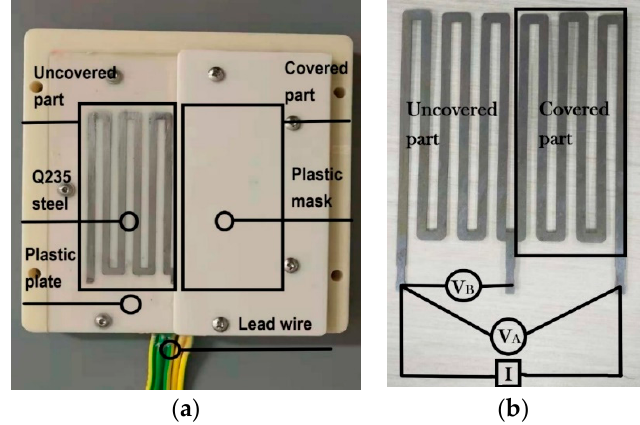
Figure 2. The schematic illustration of an electrical resistance sensor. ( a ) The appearance of an electrical resistance sensor; ( b ) Schematic diagram of detection principle of electrical resistance sensor.